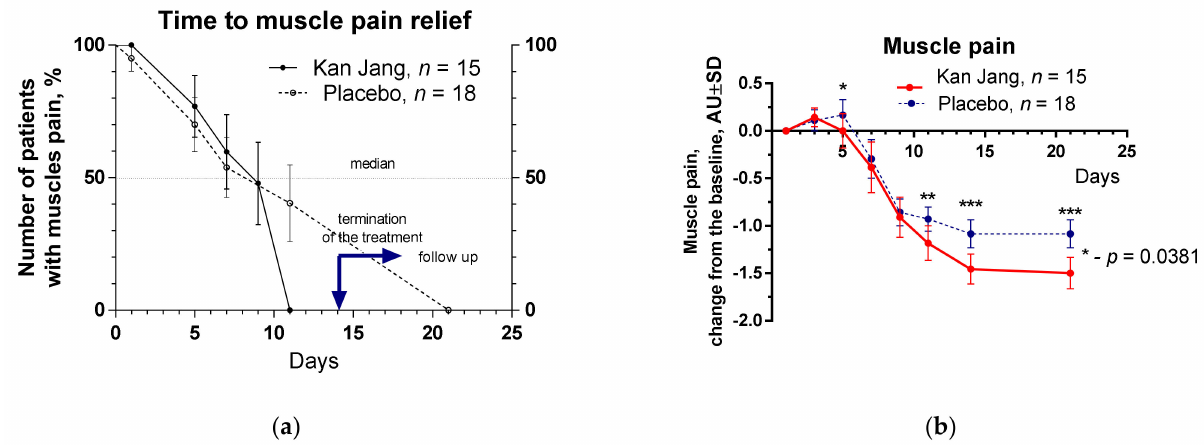
Figure 6. ( a ) Time to muscle pain relief in the treatment and control groups. Kaplan–Meier curves show the percent of patients with the muscle pain over the time from randomization (Day 1) to the end of the treatment (Day 14) and follow-up for one week (Day 21); median recovery, Kan Jang ® was 9 days, placebo was 11 days; hazard ratio Kan Jang/placebo = 1.345, 95% CI of ratio from 0.4683 to 3.863. ( b ) Relief of the muscle pain; the changes in the severity of the symptom from the baseline of patients in group A (Kan Jang) and group B (placebo) over the time from Day 1 to Day 21. Between-groups comparison of the changes in the severity of the symptom from the baseline over time shows significant interaction ( p < 0.0001). The Kan Jang ® treatment has a statistically significant effect on muscle pain relief compared to the placebo. * p < 0.05, ** p < 0.001, *** p <